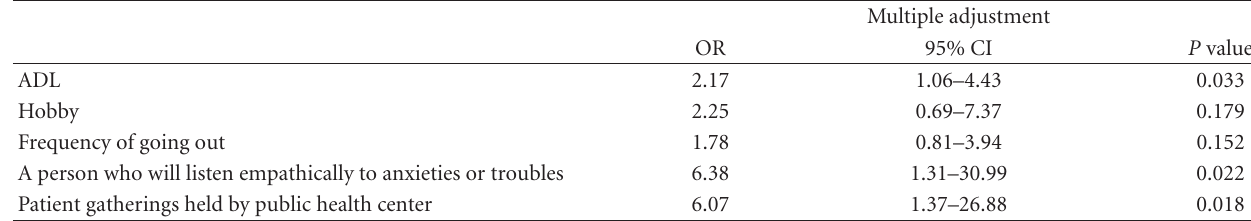
Table 3: Correlates of the total WHOQOL score (low- and high-score groups).